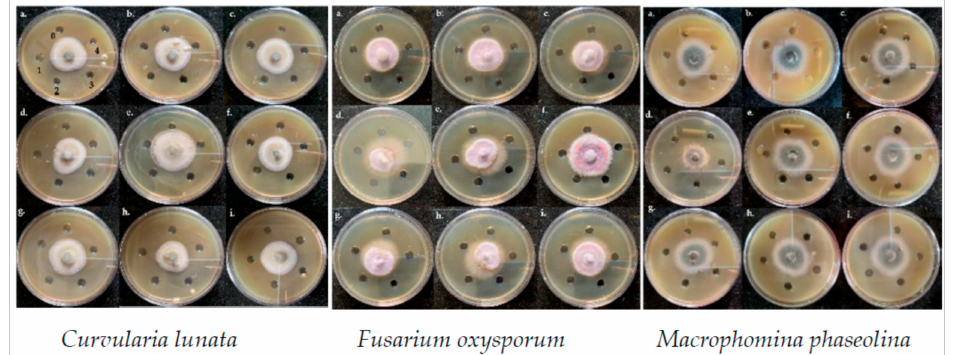
Figure 7. Effect of different ZnNPs and zinc salts on hyphal growth of three maize pathogenic cultures, Curvularia lunata, Fusarium oxysporum, and Macrophomina phaseolina. ( a ) Zinc acetate, ( b ) Zinc chloride, ( c ) Zinc sulphate, ( d ) Sodium hydroxide (RA) ZnNPs, ( e ) Thiourea (RA) ZnNPs, ( f ) Starch (RA) ZnNPs, ( g ) Bovine serum albumin (CA) ZnNPs, ( h ) Starch (CA) ZnNPs, and ( i ) Cellulose (CA) ZnNPs. The figures from 0 to 4 indicate different concentrations of the zinc salts and ZnNPs. 0 = distill water, 1 = 5 mg L − 1 , 2 = 10 mg L − 1 , 3 = 20 mg L − 1 , 4 = 40 mg L −